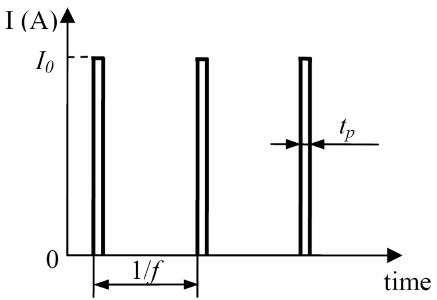
Figure 2. Schematic drawing of the pulsed electric current.